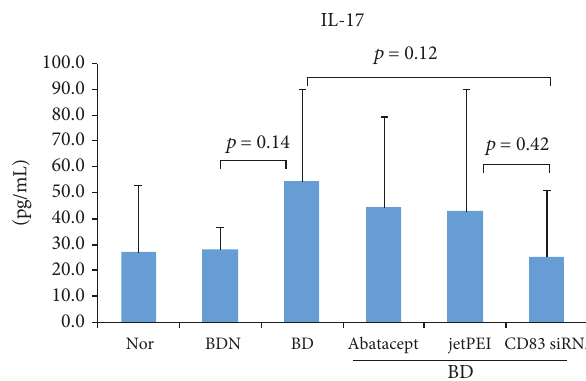
Figure 4: Serum interleukin 17 (IL-17) levels in BD mice after being treated with CD83 siRNA were analyzed by ELISA. Data represent two independent